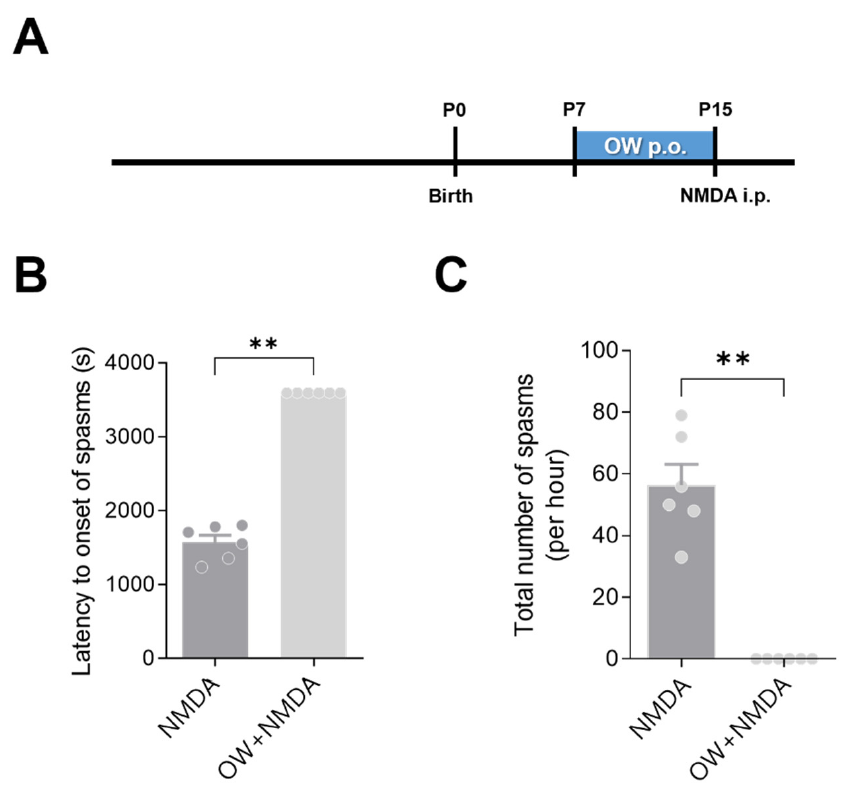
Figure 2. Effect of OW in infant rats following intraperitoneal NMDA injections. ( A ) OW was administered orally to infant rats during 9 days before NMDA injections. ( B ) Latency (seconds) and ( C ) frequency (per hour) to the onset of flexion spasms induced by intraperitoneal NMDA measured in the control and OW-treated P15 rats. OW treated group did not show spasms. Error bars denote SEM. One-way ANOVA, Newman–Keuls post hoc test: ** p <